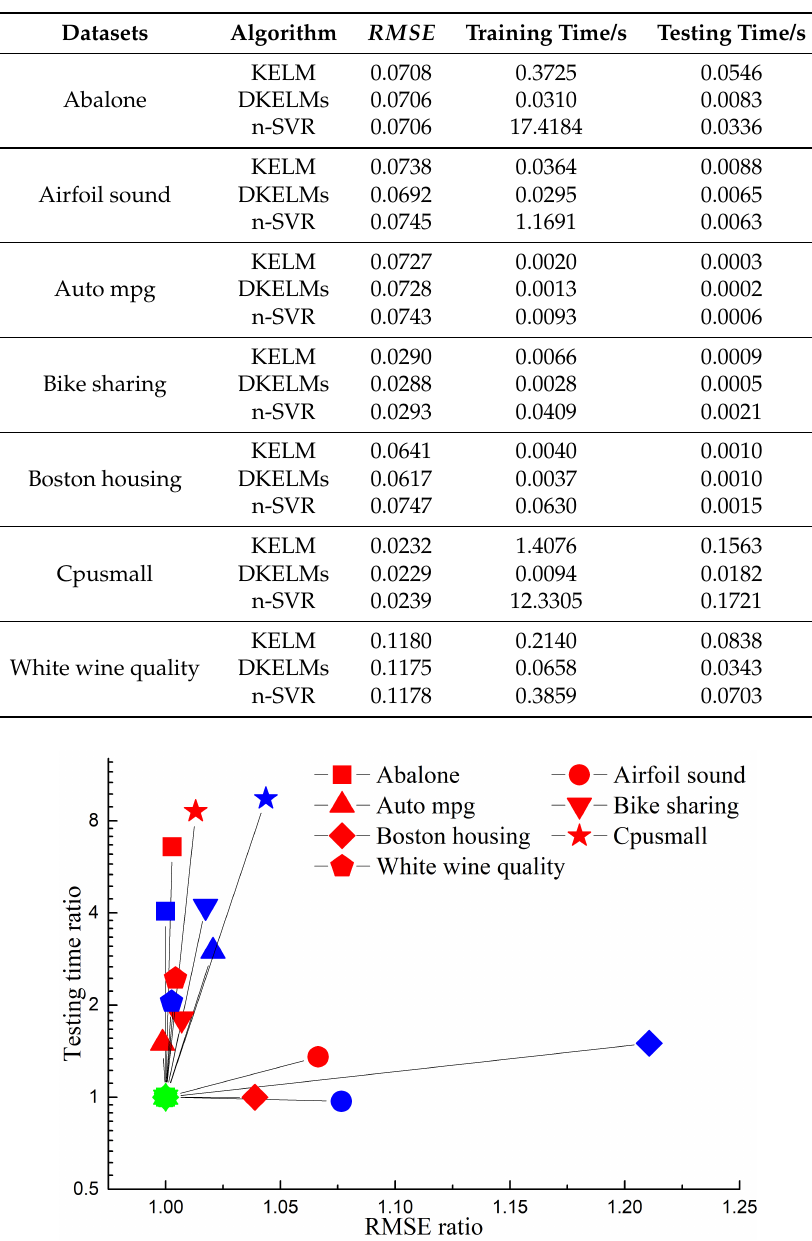
Figure 3. Comparison on RMSE and testing time in regression benchmark datasets. (Red, blue and green respectively represent the original KELM, n-SVR and DKELMs algorithms. Different legend shapes represent different